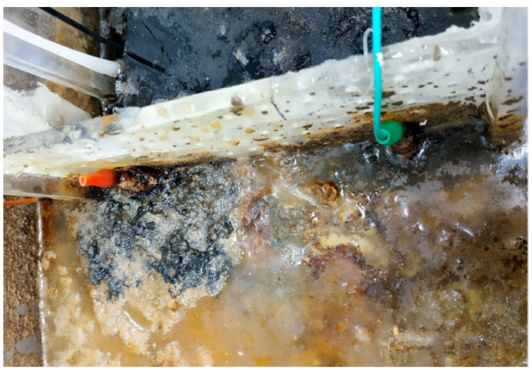
Figure 15. The negative electrode solution and the zone around the graphite bars are colored black after